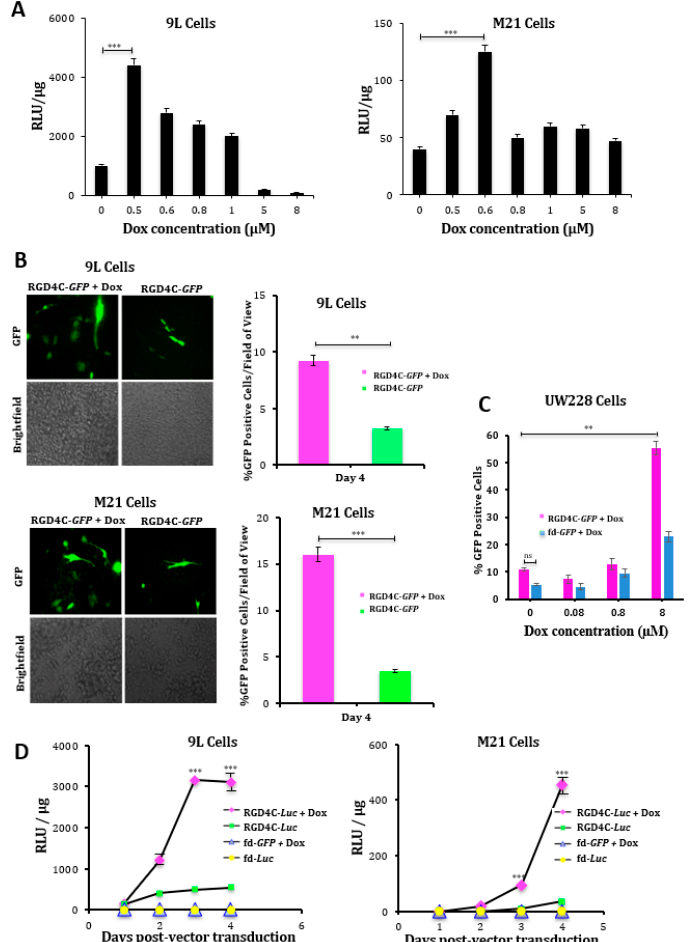
Figure 1. Doxorubicin (Dox) boosts targeted gene delivery by the RGD4C / adeno-associated virus phage (AAVP) vector in rat glioma (9L) and human melanoma (M21) cancer cells. ( A ) Determination of optimal Dox doses in 9L and M21 cells using a luciferase assay. The 9L and M21 cells were transduced with the targeted RGD4C / AAVP- Luc ( luciferase ) vector carrying a luciferase ( Luc ) reporter gene, in combination with increasing concentrations of Dox ranging from 0.5 to 8 µ M for 24 h. To evaluate gene delivery, a luciferase assay was performed at day 3 post-transduction. The results were normalized to the amount of protein, as determined by the Bradford assay, and shown as relative luminescence units (RLU) / µ g of protein. ( B ) Evaluation of the gene expression in 9L and M21 cells in the presence of optimal Dox concentrations (0.5 µ M for 9L and 0.6 µ M for M21 cells). Tumor cells were plated in 48-well plates and transduced with the targeted RGD4C / AAVP- green fluorescent protein ( GFP ) (RGD4C- GFP ) vector carrying a GFP reporter gene in the presence or absence of Dox. GFP expression was evaluated by fluorescent microscopy at day 4 post-vector transduction. GFP expression is also displayed as the average of GFP-positive cells in five fields of view of treated 9L and M21 cells. Original magnification × 200 for GFP and × 40 for brightfield images. ( C ) Fluorescence-activated cell sorting (FACS) analysis of GFP expression in UW228 medulloblastoma cells at day 5 post-transduction with RGD4C- GFP or nontargeted (fd- GFP ) vectors with varying concentrations of Dox ranging from 0.08 to 8 µ M for 24 h. ( D ) Evaluation of the e ff ect of Dox on gene delivery over a time course. The 9L and M21 cells were plated in 48-well plates and transduced with the targeted RGD4C / AAVP- Luc (RGD4C- Luc ) vector or control nontargeted AAVP- Luc (fd- Luc ) in serum-free medium in the presence or absence of Dox 0.5 µ M and 0.6 µ M for 9L and M21 cells, respectively. Luciferase measurement assays were performed at various time points from days 1 to 4 post-vector transduction and normalized to protein concentrations. Results are shown as RLU per 1 µ g of protein. All experiments were repeated twice, in triplicates, and the results shown are representative of one experiment. ** p < 0.01 and *** p <